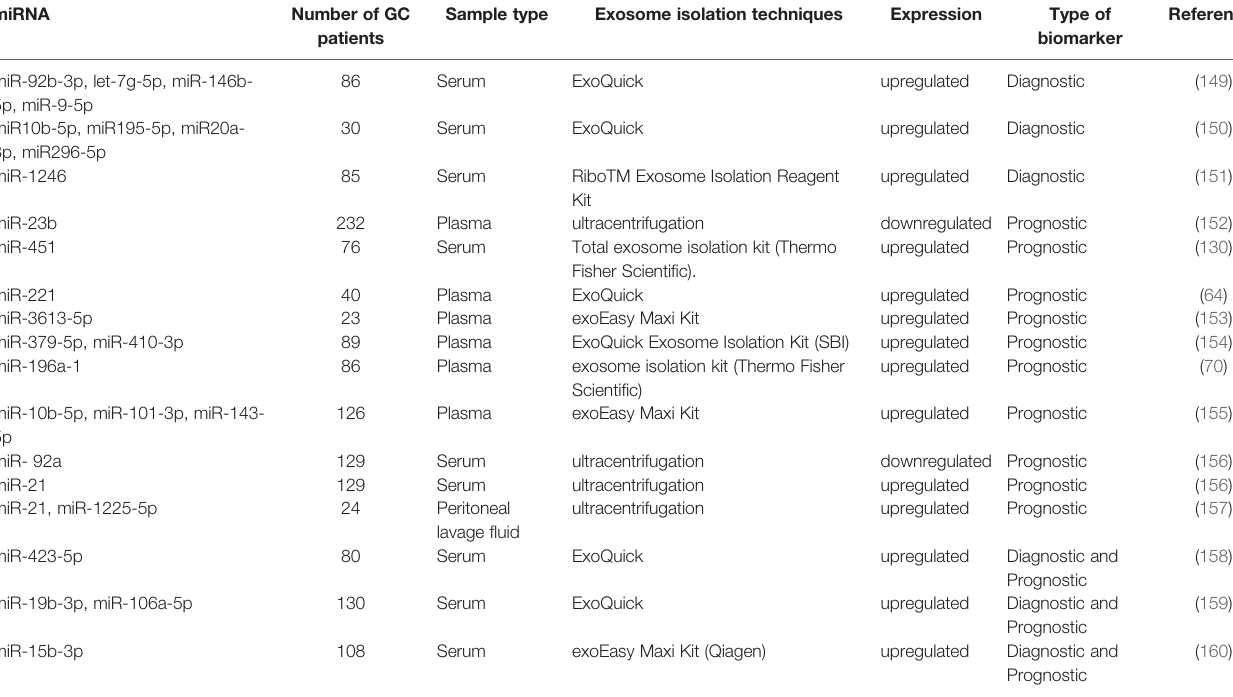
TABLE 2 | The potential biomarker of exosomal miRNA in GC.